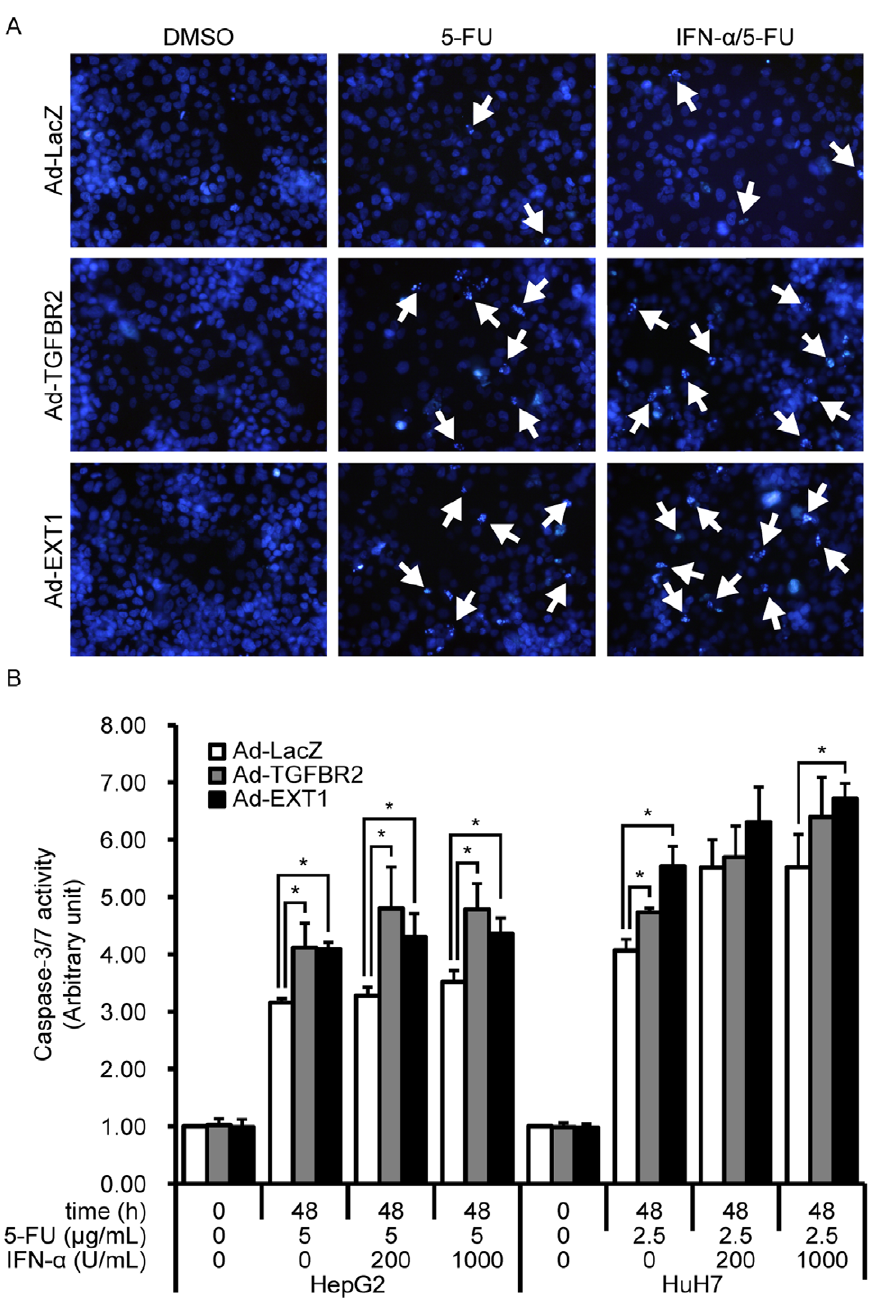
Figure 3. Enhancement of IFN- a /5-FU-induced apoptosis by TGFBR2 and EXT1 overexpression. (A) Evaluation of nuclear condensation. The arrows indicate cells with apoptosis-specific nuclear condensation and fragmentation. (B) Measurement of intracellular caspase 3/7 activity. After adenovirus infection, cells were treated with the indicated concentrations of IFN- a and 5-FU. Activity was expressed as the fold increase relative to that at 0 h. Data are expressed as mean 6 standard deviation ( n= 3). Statistical significance was determined using Student’s t -test. * P , 0.05 compared to LacZ at 48 h.